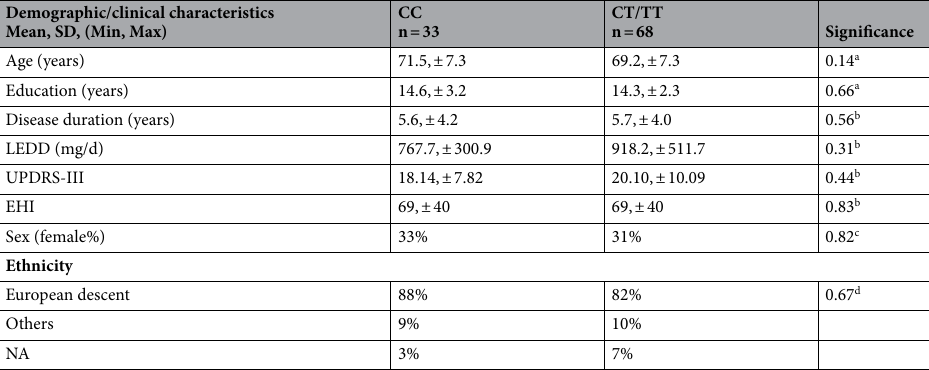
Table 3. Demographic and clinical characteristics of the two groups of rs894280 variant. Abbreviations; SD = Standard Deviation, LEDD = Levodopa Equivalency Daily dosage, UPDRS-III = Unified Parkinson’s disease Rating Scale part III, EHI = Edinburg Handedness Inventory, NA = Not available. a Student-t test. b Mann–Whitney U test. c Fisher exact test. d Chi-square test.